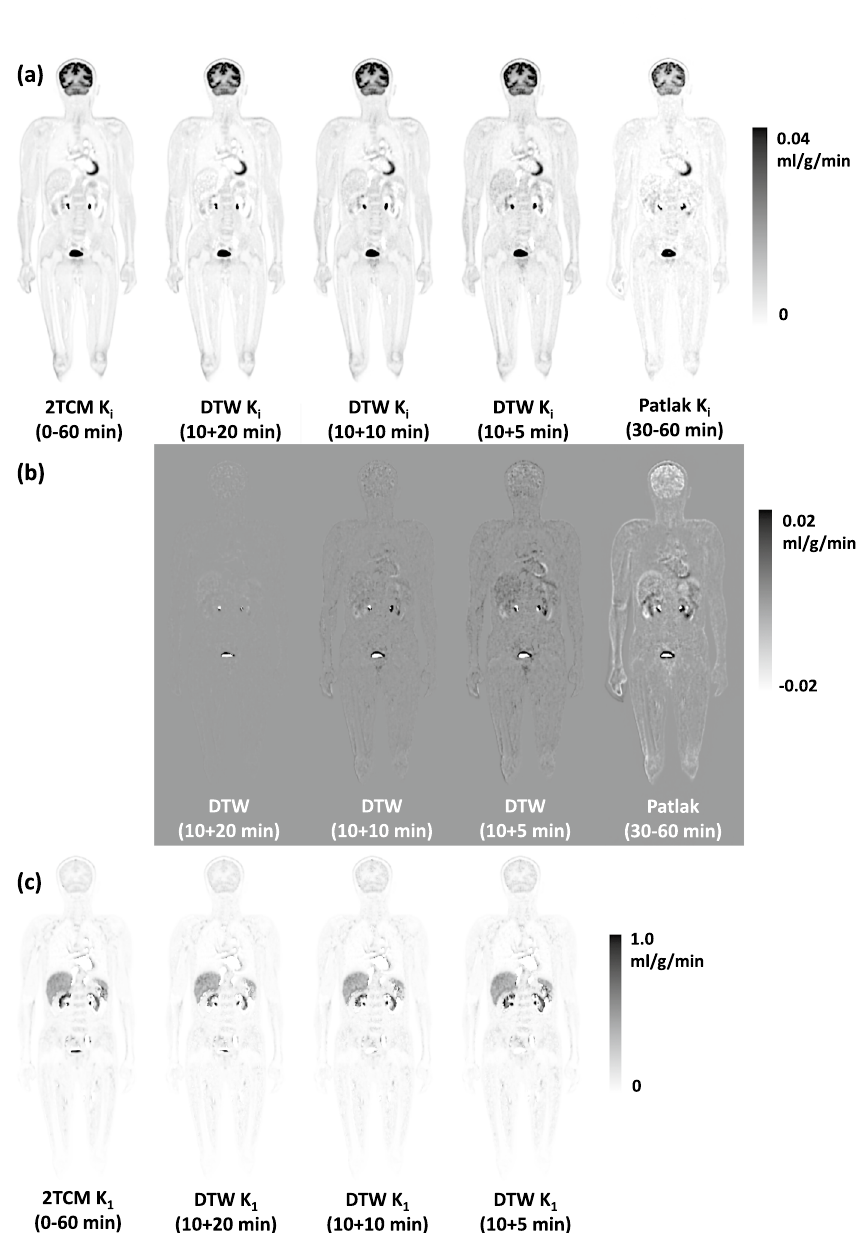
Fig. 6 Whole-body parametric images from a dynamic scan: ( a ) K i images generated from the 60-min full scan, the DTW protocols, and Patlak analysis; the muscle region inside the red box was sampled to quantify the image noise; ( b ) difference images between the ones and the reference K i image from 60-min full scan; ( c ) K 1 images generated from the 60-min full scan and the DTW